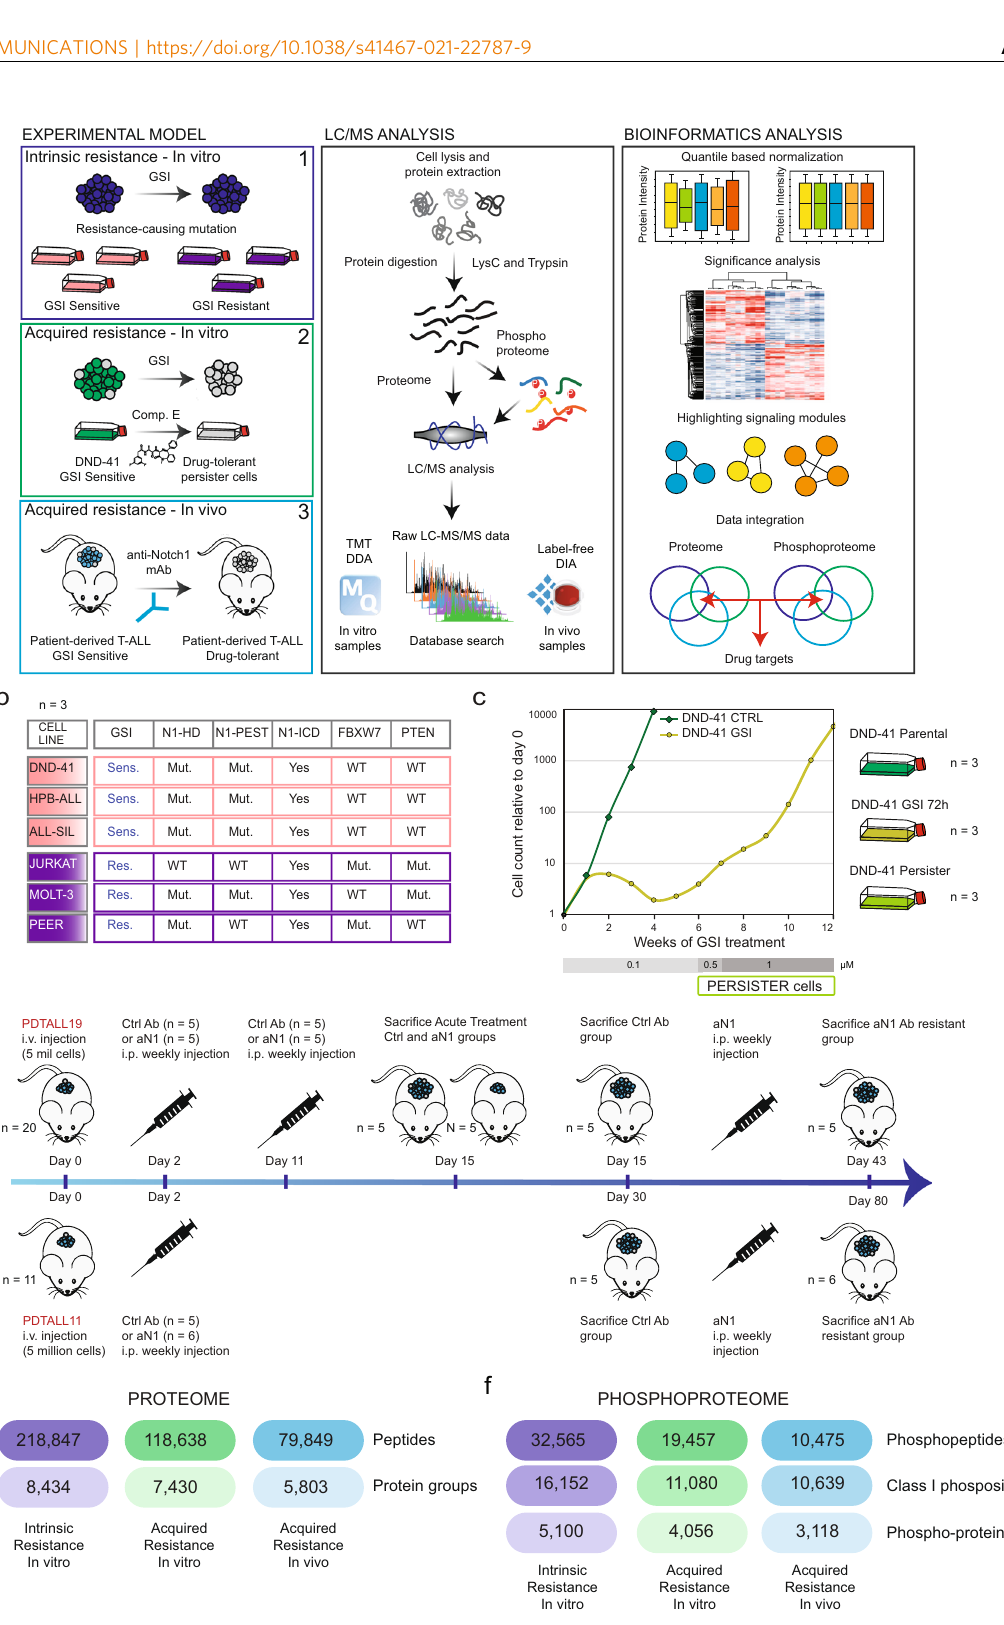
Sacrifice aN1 Ab resistant